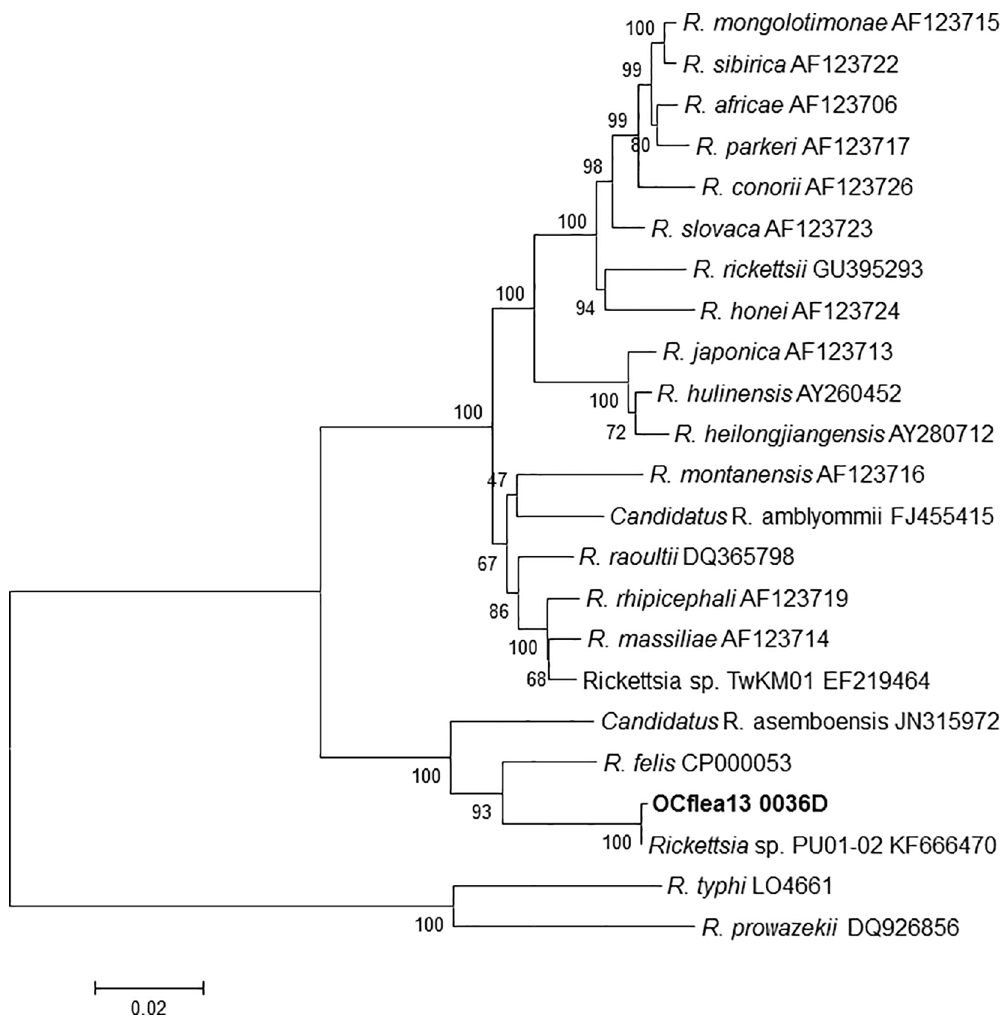
Fig 2. Dendogram of partial sequences of ompB gene of rickettsiae from GenBank and OCflea13 0036D detected in Ctenocephalides felis obtained from opossums and cats in Orange County, California. The tree was inferred using Maximum Likelihood method involving rickettsiae detected in this study and 22 historical strains provided in GenBank.